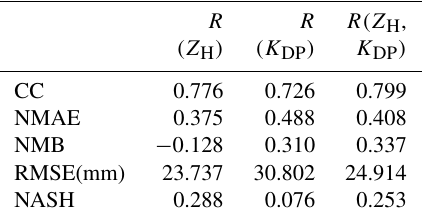
Table 8. Verification of the radar-based rainfall monthly accumula- tion products of Italy. Z H is not corrected for